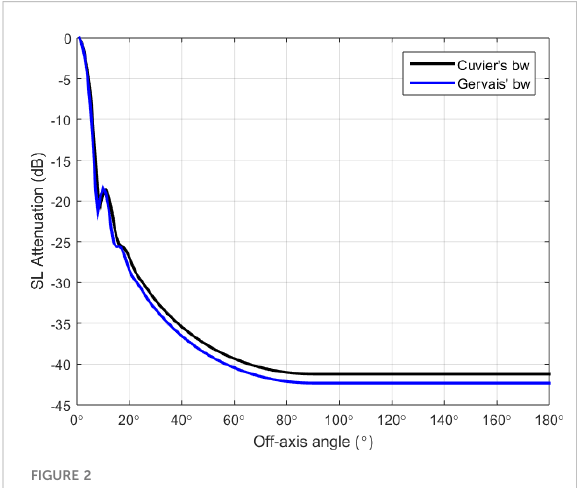
FIGURE 2 Attenuation of source levels as a function of off-axis angle for Cuvier ’ s and Gervais ’ beaked whales, estimated by using a piston model with radius of 16